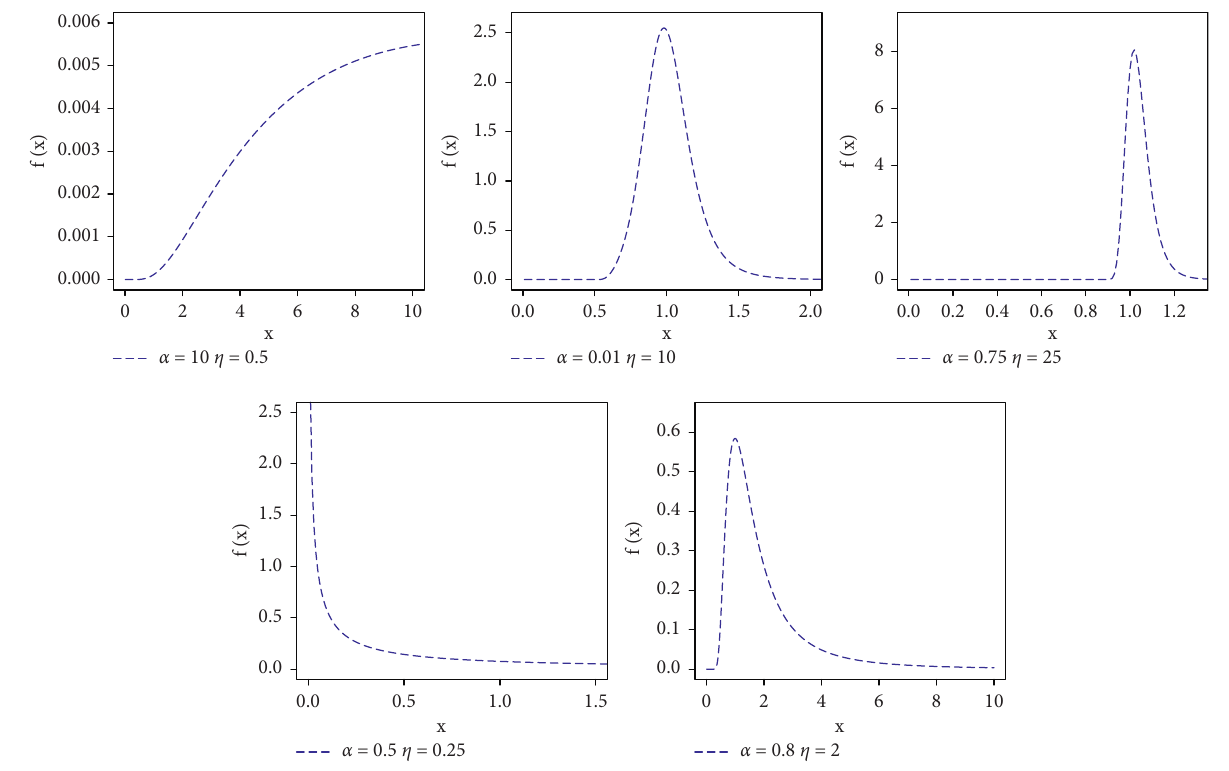
Figure 1: Possible density shapes of the IPBH distribution for several values of α and η .